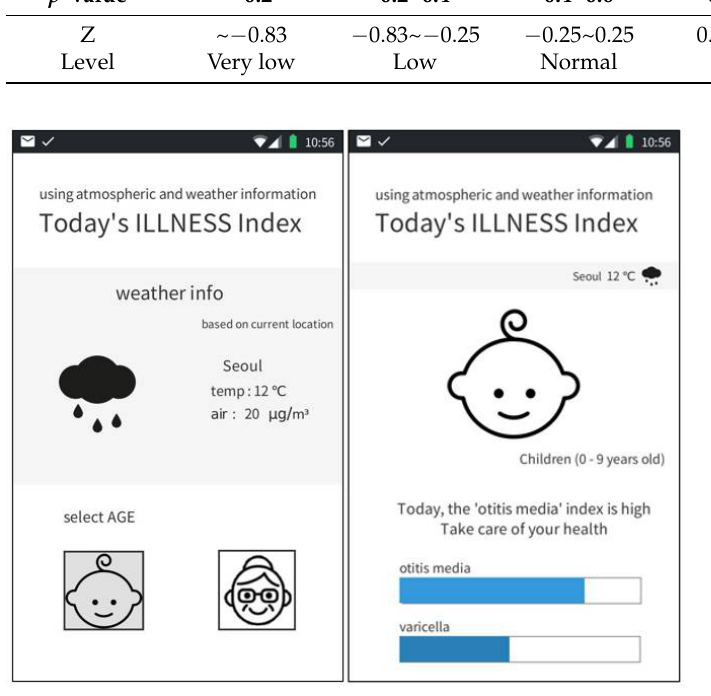
Figure 1. Application. Figure 1.